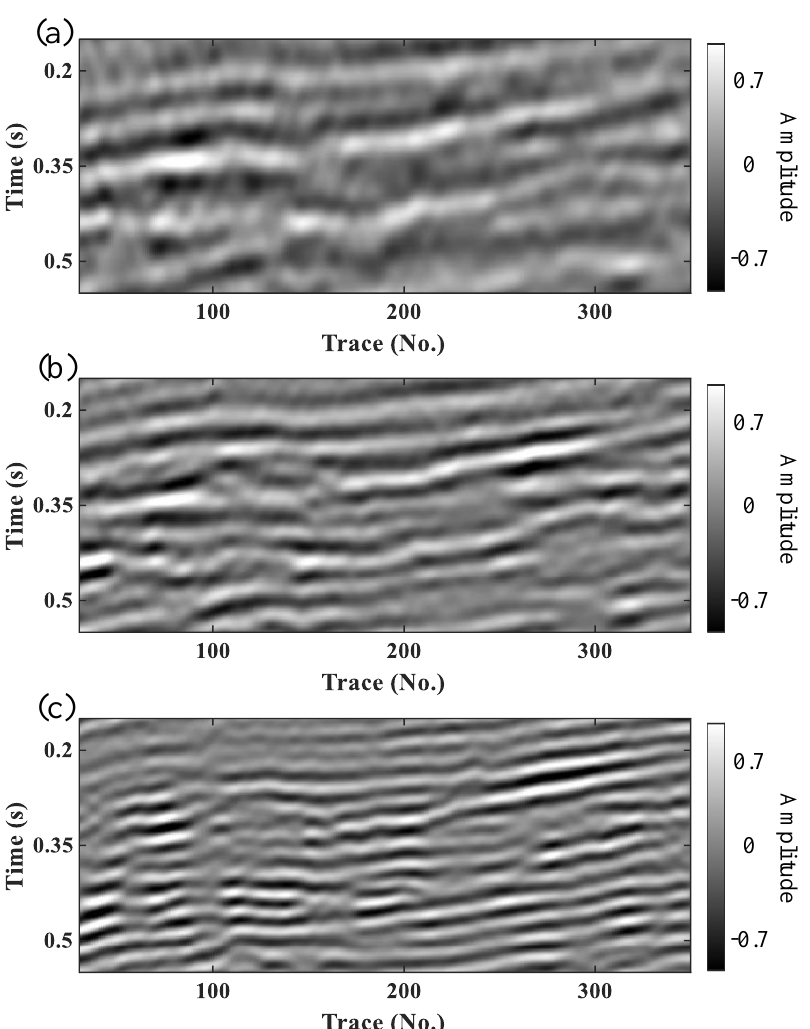
Figure 9. Multi-scale seismic data: ( a ) Low frequency data. ( b ) Medium frequency data. ( c ) High frequency data.